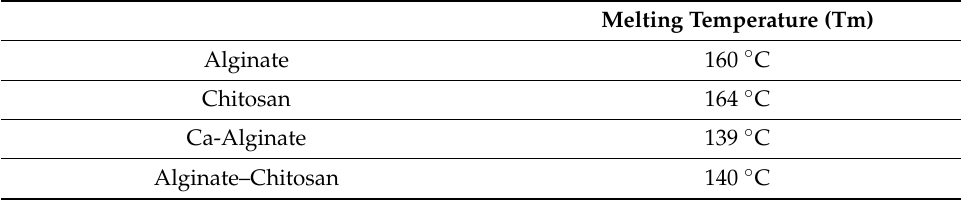
Figure 11. DSC pattern of calcium alginate composite microspheres. Table 5. Melting temperature (Tm) of DSC spectrum.